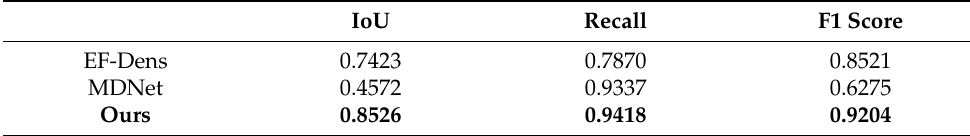
Table 2. The evaluation metrics results of ablation I